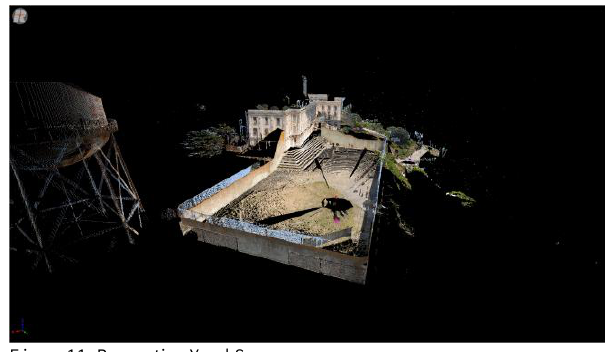
Figure 11. Recreation Yard Scan